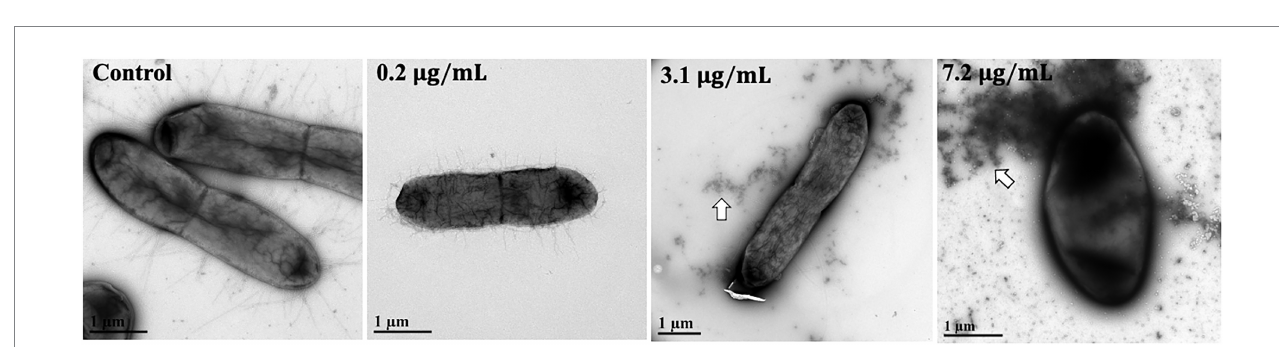
FIGURE 7 TEM images of AgNP-treated E. coli cells. E. coli cells were incubated for 6 h with (left to right) H 2 O control, 0.2 μ g/mL, 3.1 μ g/mL, and 7.2 μ g/mL. The samples were immediately fixed to Formvar/carbon grids. Each grid was stained for 20 s with 0.5% uranyl acetate and imaged with Tecnai G2 Spirit TWIN 120 kV TEM. While arrows point to the observed dark staining of the extracellular matrix. Scale bars = 1 μ